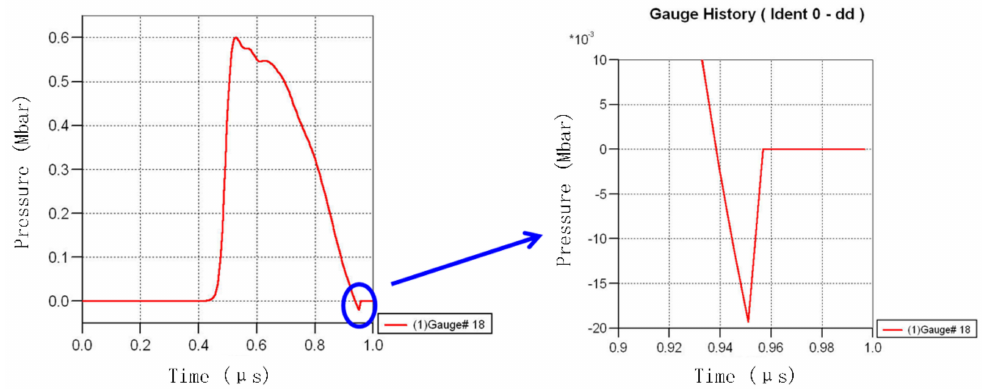
Figure 9. Pressure − time − history curve of observation point at spalling